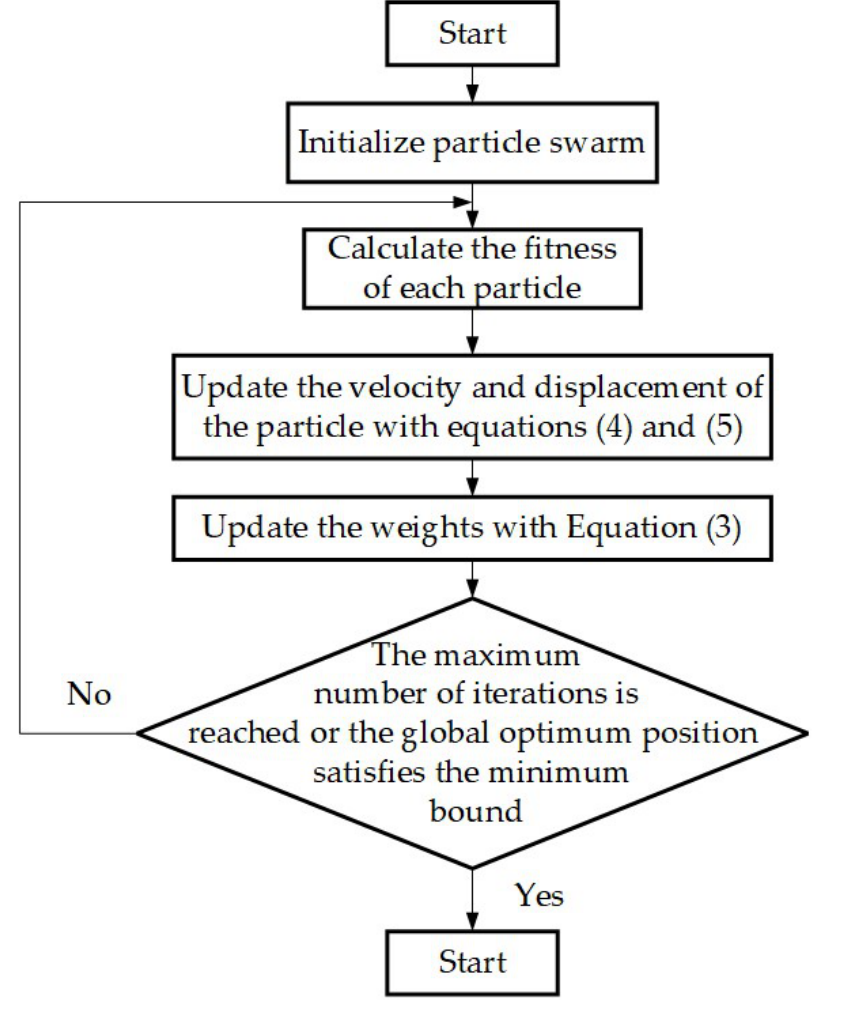
Figure 3. Flow chart of the IPSOARW.